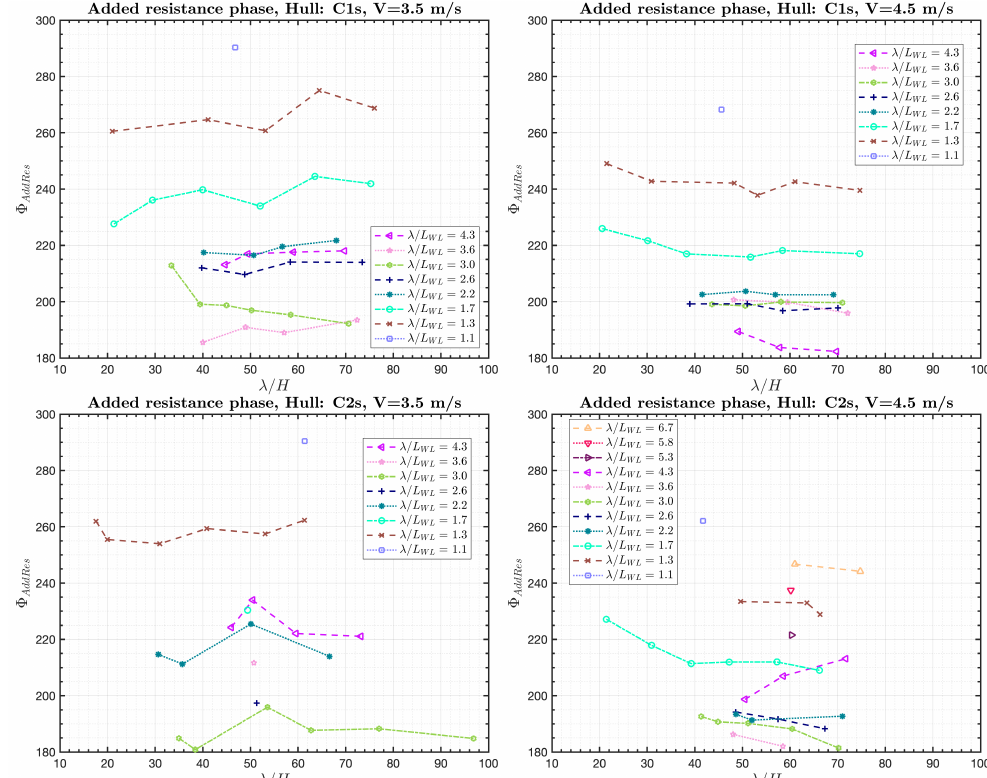
Figure 14. Added resistance phase vs. λ / H